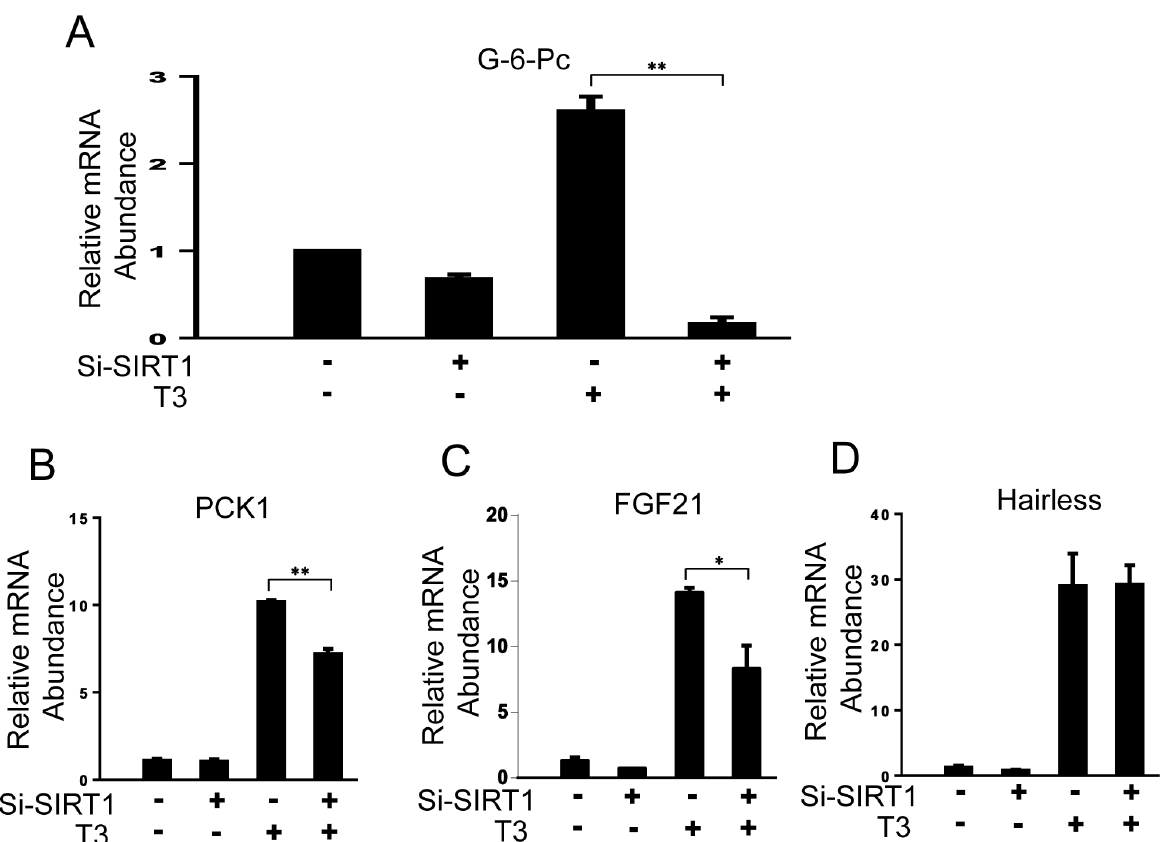
Figure 6. SIRT1 knockdown inhibits some TR b 1 target genes. (A–D) qPCR analysis of HepG2-TR b 1 cells extracts treated + / 2 T 3 and SIRT1 siRNA. G-6-Pc (A), PCK1 (B), FGF21 (C) and Hairless HR (D). The data are representative of at least three independent experiments. All values represent the mean 6 SD of duplicate samples. **, P , 0.01; *, P , 0.05.